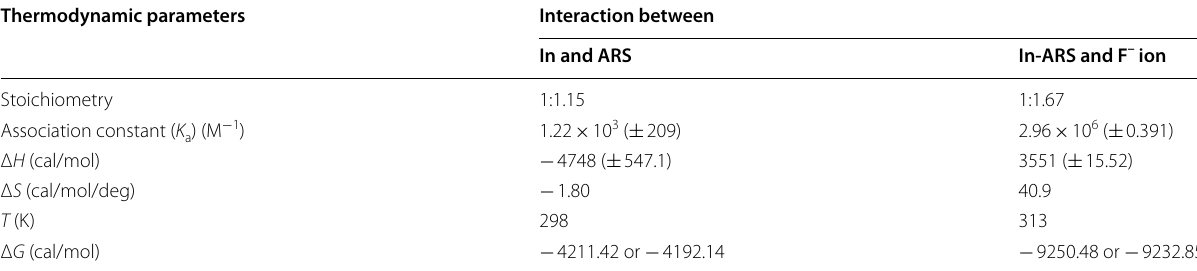
Table 3 Thermodynamic parameters for the interaction between In with ARS and In-ARS complex with F Thermodynamic parameters Interaction between